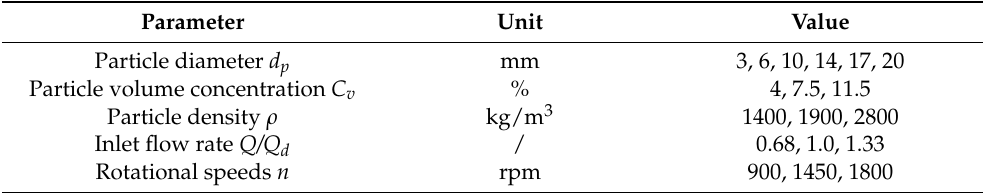
Table 2. Numerical calculation scheme